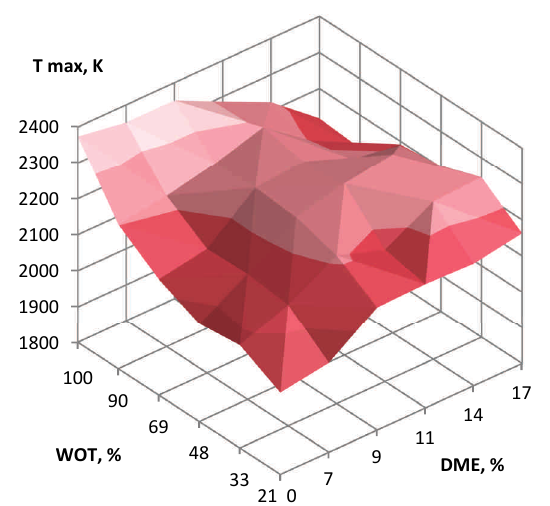
Fig. 17. An influence of DME share & engine load on emission CO 2 , λ = 1.0, n = 2500 rpm